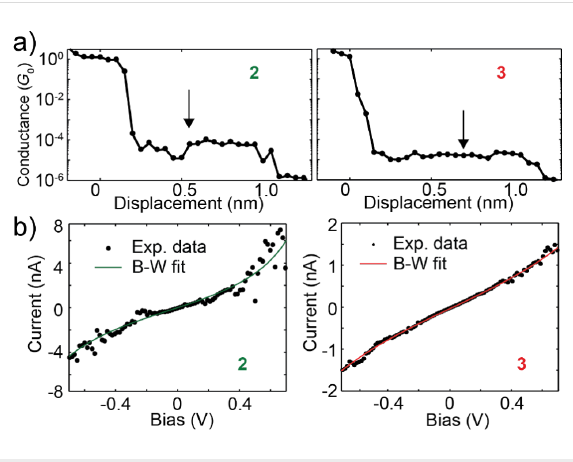
Figure 4: (a) Conductance versus displacement traces of the mole- cules 2 and 3 . The conductance is extracted from a linear fit of the current at low bias of each I – V measured during the stretching oh the molecular junction. (b) Two I – V curves, measured in the points indi- cated by the arrows in (a). The solid line corresponds to a single-level model fit to the data, the parameters of the fit are: 2 ( ε 0 = 0.55 eV, Γ = 4 meV) and 3 ( ε 0 = 0.71 eV, Γ = 2